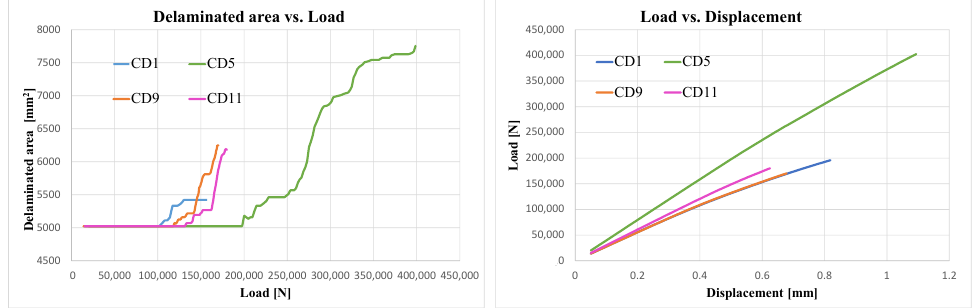
Figure 13. Delaminated area vs. load and load vs. displacement charts. Comparison against CD1, CD5, CD9 and CD11 configurations.